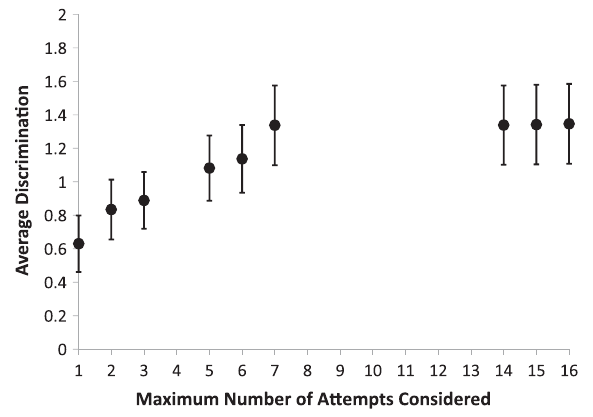
FIG. 7. Average discrimination of the homework items as a function of the maximum number N of considered attempts. Missing data points indicate that the fit did not converge. The error bars indicate the average of the standard errors on the